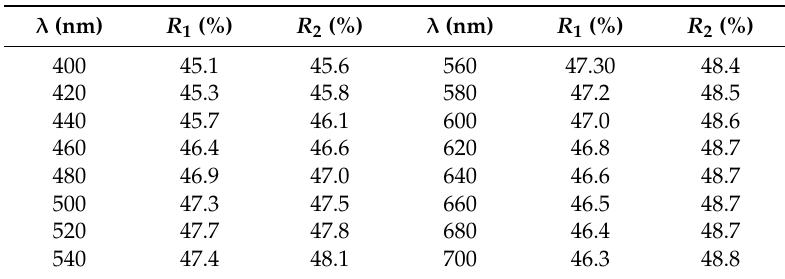
Table 1. Reflectance data for